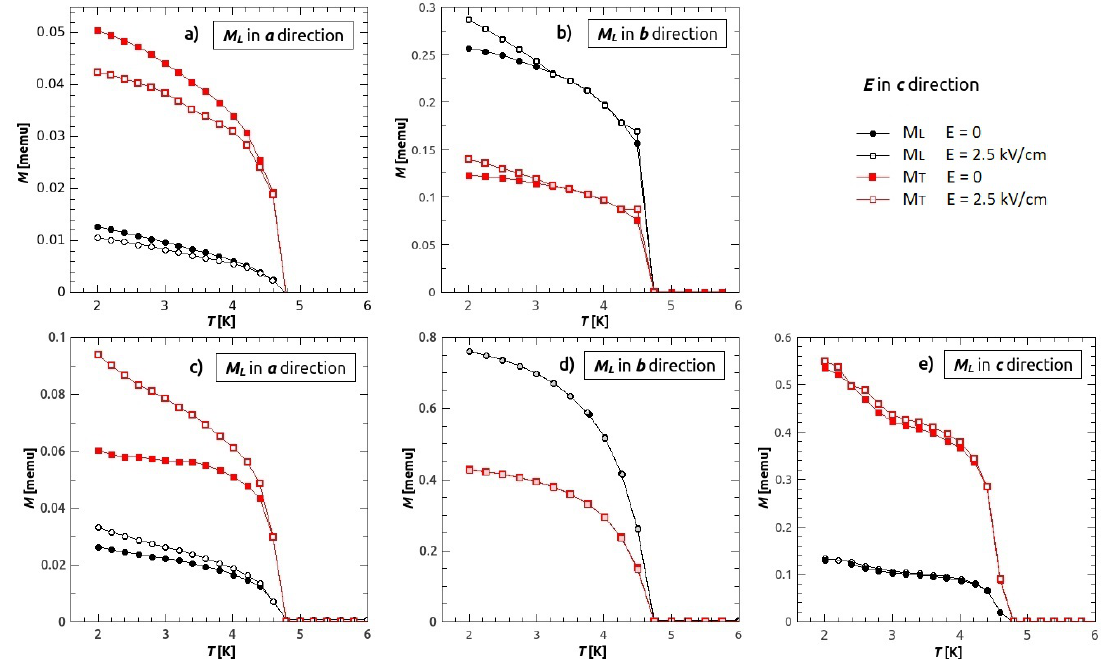
Figure 9. Magnetoelectric effect. Five different measurement setups, ( a , b ) measurements in H = 0 Oe, directly after cooling the superconducting magnet (no remanent fields). ( c – e ) after using the magnet (unknown remanent field). Black circles represents longitudinal magnetization, while red rectangles transverse magnetization. Filled symbols represent the mag- netization measured in zero electric field, while empty symbols magnetization measured in electric field ( E ≈ 2.5 kV/cm) applied in c